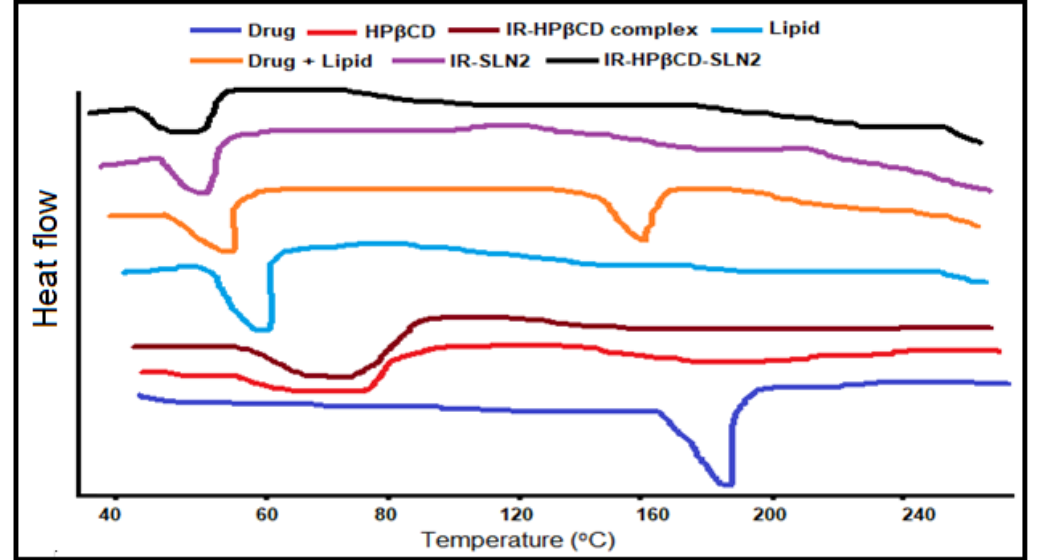
Figure 4. DSC curves of IR, HP- β CD, freeze-dried IR/HP- β CD inclusion complex (1:1 molar ratio), Dynasan 112, PM of IR, and Dynasan 112, freeze-dried IR-SLN2, and freeze-dried IR-HP- β CD-SLN2 formulations.